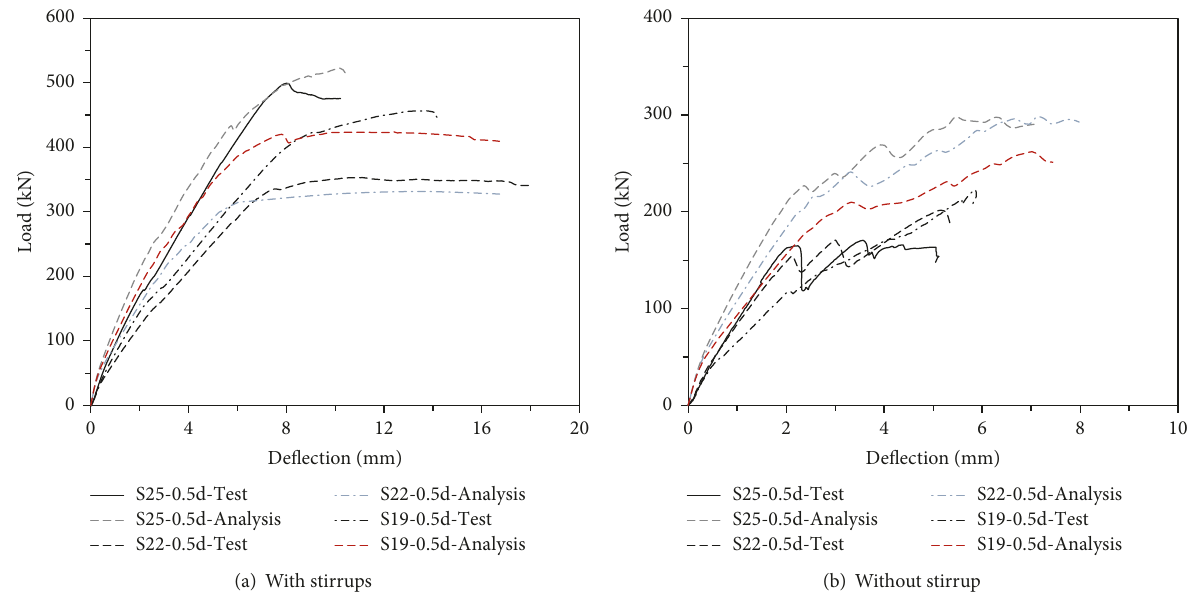
Figure 15: Comparison of experimental and analytical load-displacement curves for shear test